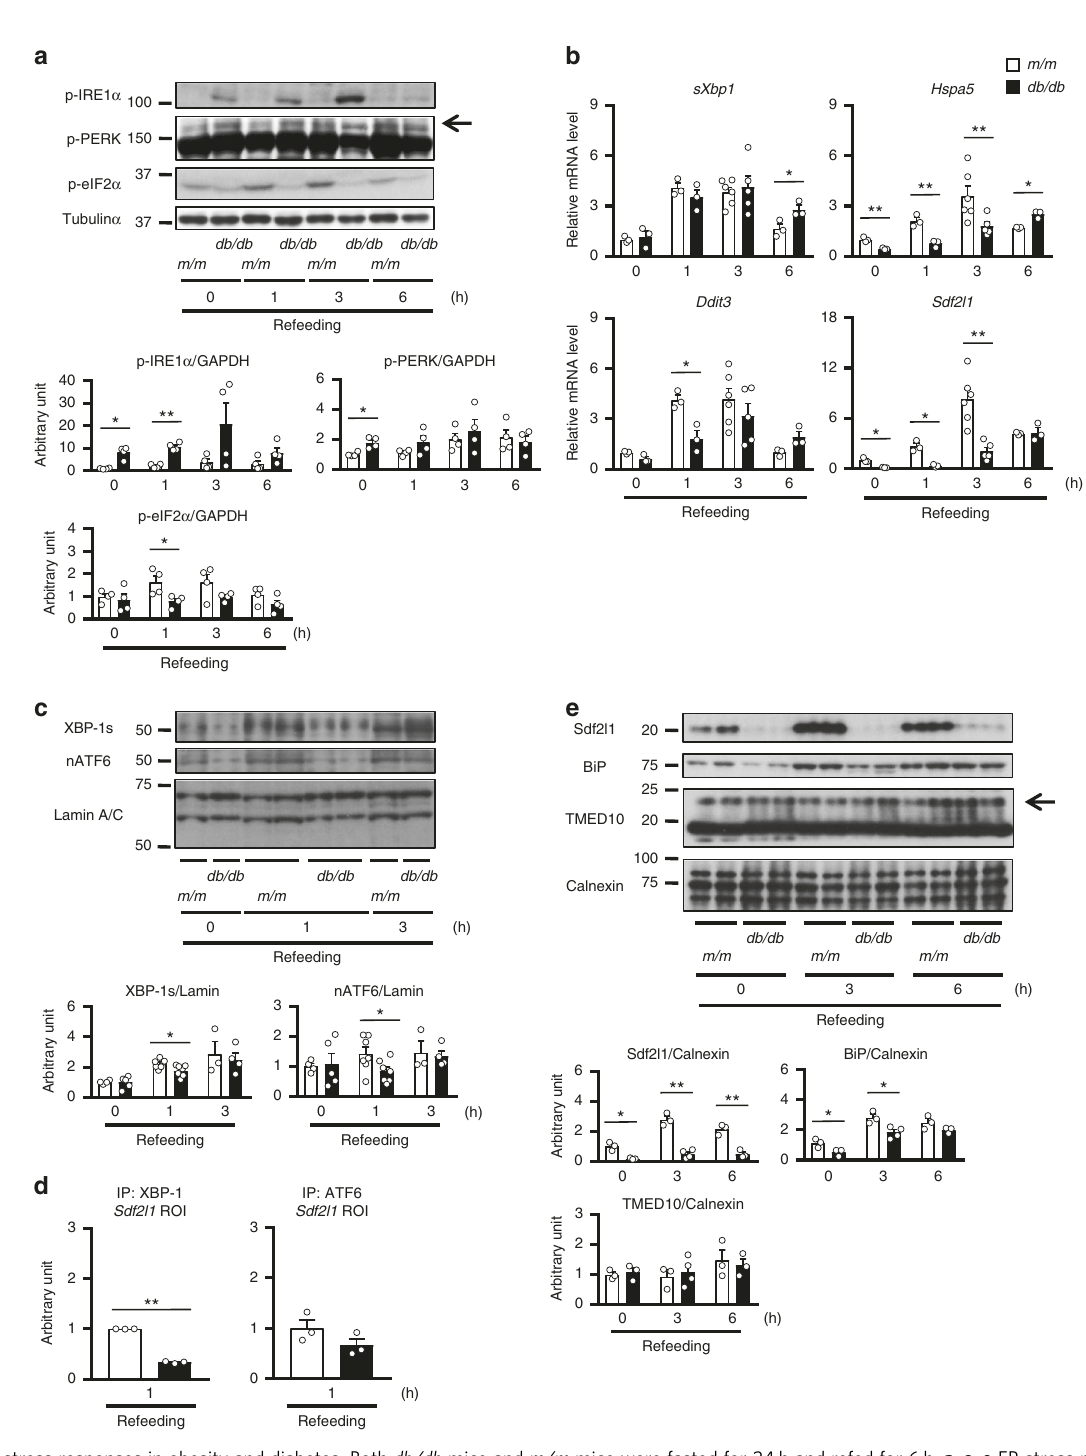
Fig. 5 ER stress responses in obesity and diabetes. Both db/db mice and m/m mice were fasted for 24 h and refed for 6 h. a – c , e ER stress markers were analyzed by a Western blotting of total lysates ( n = 4), b RT-PCR ( n = 3 – 6), c Western blotting of nuclear extracts ( n = 3 – 7), and e Western blotting of microsomal fractions ( n = 3 – 4). d ChIP assay, using antibodies recognizing XBP-1 or ATF6, for analysis of binding of transcription factors with the Sdf2l1 promoter in the liver, in a 1-h refed state after 24 h of fasting ( n = 3). The relative expression levels were normalized by the upstream region ( − 3.5 kb) and then by control IgG (rabbit or mouse IgG, respectively). Values of the data are expressed as mean ± SEM. * P < 0.05, ** P < 0.01. Unpaired 2-tailed t -test was used for